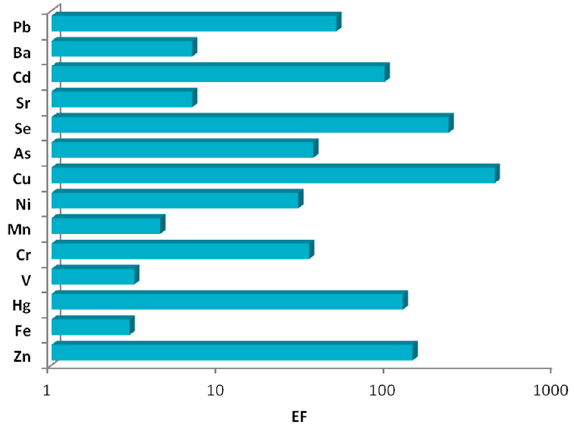
Figure 3. Enrichment factor (EF) of elements in house dust.